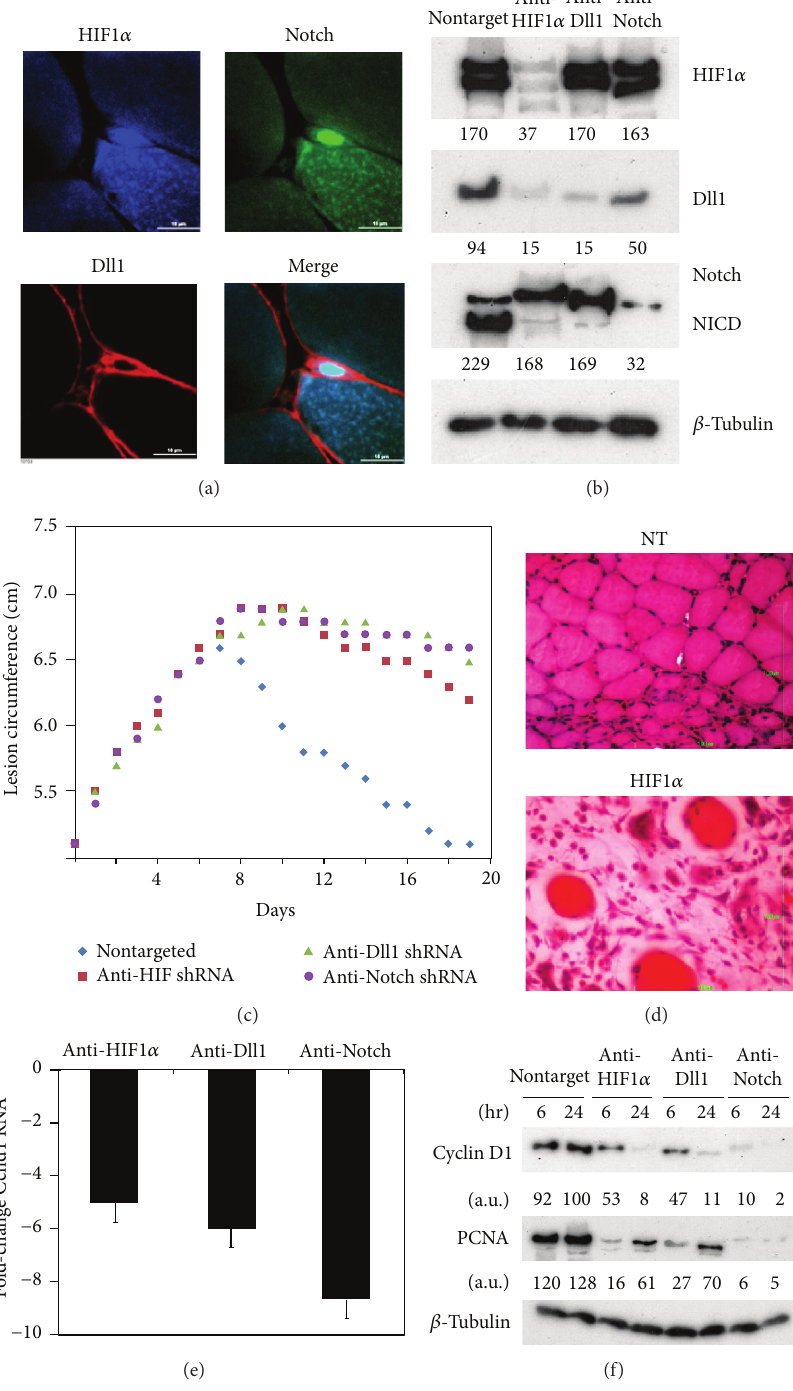
Figure 3: HIF-Dll-Notch axis in pcRNA-induced myogenesis. (a) A triple-stained section of injured quadriceps muscle treated with pcRNA1– 3 combination for 4.5 h, showing HIF1 𝛼 (blue) concentrated in the nucleus of an activated satellite cell, colocalizing with Notch (green) and Dll1 (red) attached to the plasma membrane as well as the plasma lemma of the underlying myofiber. Scale bar, 10 𝜇 m. (b) Effect of RNA interference on protein expression in injured muscle infected for 2d with lentivirus expressing shRNA targeted against the indicated mRNAs and then administered pcRNA1–3 for 6 or 24 h, before western analysis of indicated proteins. (c) Effect of knockdown of the indicated proteins on wound resolution. (d) Hematoxylin-eosin stain of lentivirus-infected injured muscle expressing nontargeted (NT, upper) or HIF1 𝛼 -targeted shRNA (lower), treated with pcRNA for 2 weeks. Scale bar, 100 𝜇 m. (e) Fold-change in cyclin D1 (Ccnd1) mRNA level, relative to nontargeted control, in injured muscle knocked down for the indicated protein and treated with pcRNA for 6h, determined by Q-PCR. (f) Western blots of nontargeted or targeted muscle treated with pcRNA1–3 for 6 or 24 h, probed for Ccnd1, PCNA, or 𝛽